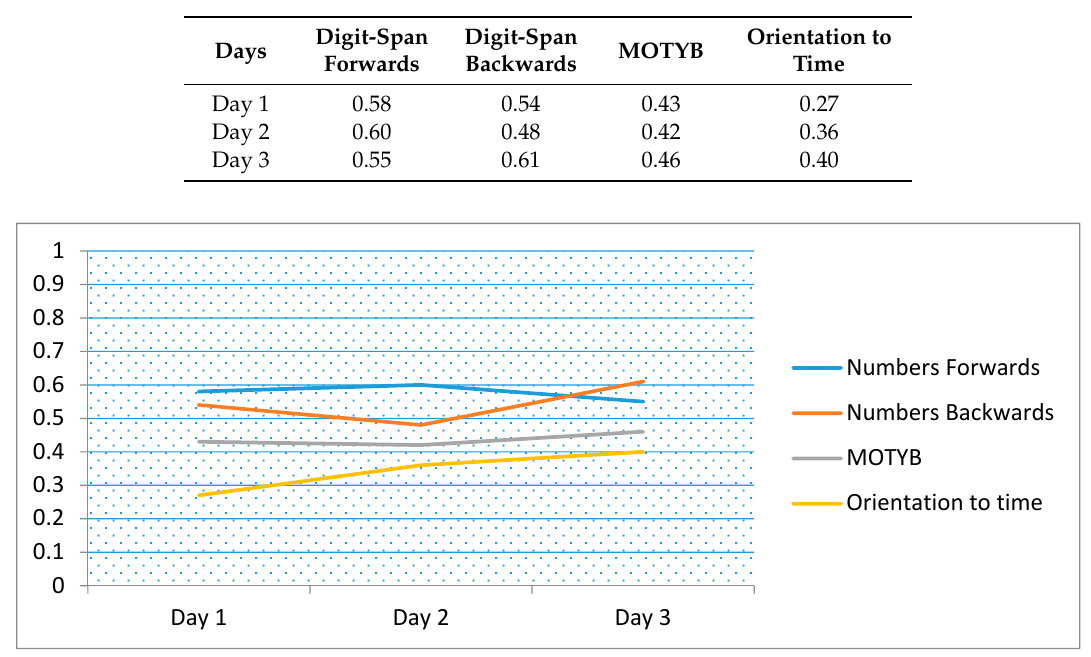
Figure 1. Correlation coefficients for logical memory compared to short tests of attention including months of the year backwards (MOTYB) and orientation (time of the day), over time (days 1 to 3). (Note: 83/84 with complete data included).